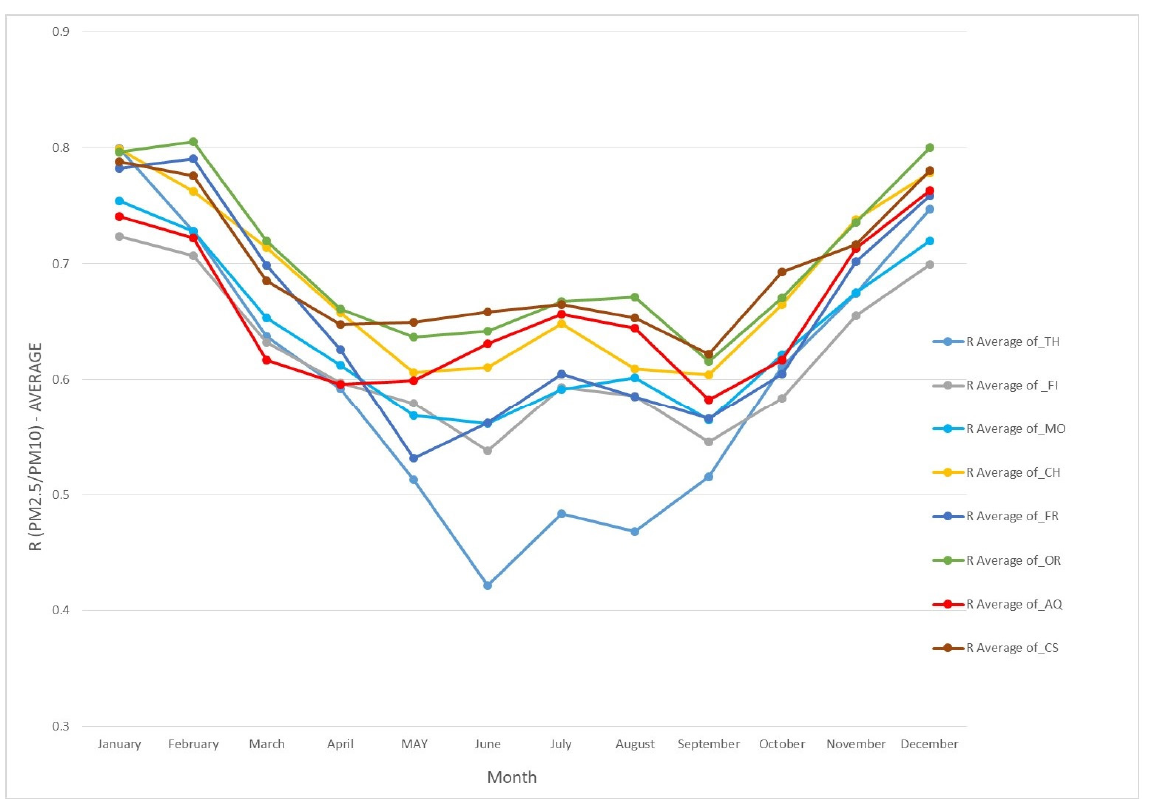
Figure 5. Graph of the monthly average values of R (PM2.5/PM10 ratio) in the eight stations of the regional network in the two-year period 2017–2018. Table 4. Summary table of the average of daily values of the PM2.5/PM10 ratio in the eight stations of the network in the two-year period 2017–2018 average value in the summer semester, in the win- ter semester, and for the whole year.